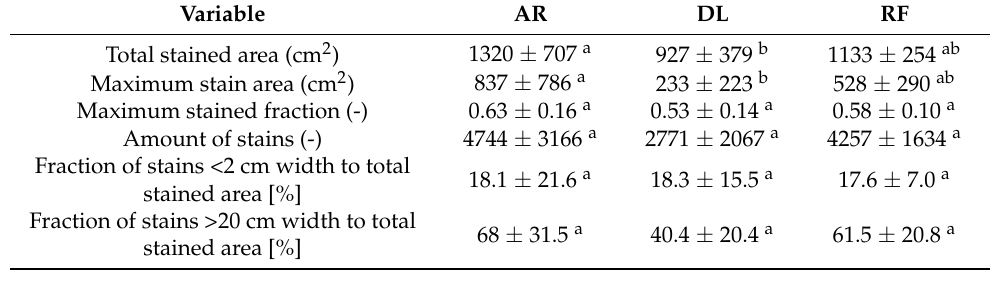
Table 2. Median ( ± standard deviation) values of the results of the blue dye experiments. Different superscript letters denote statistically significant differences between land-cover types ( p < 0.05). AR, Active restoration; DL, Degraded land; RF, Reference forest.